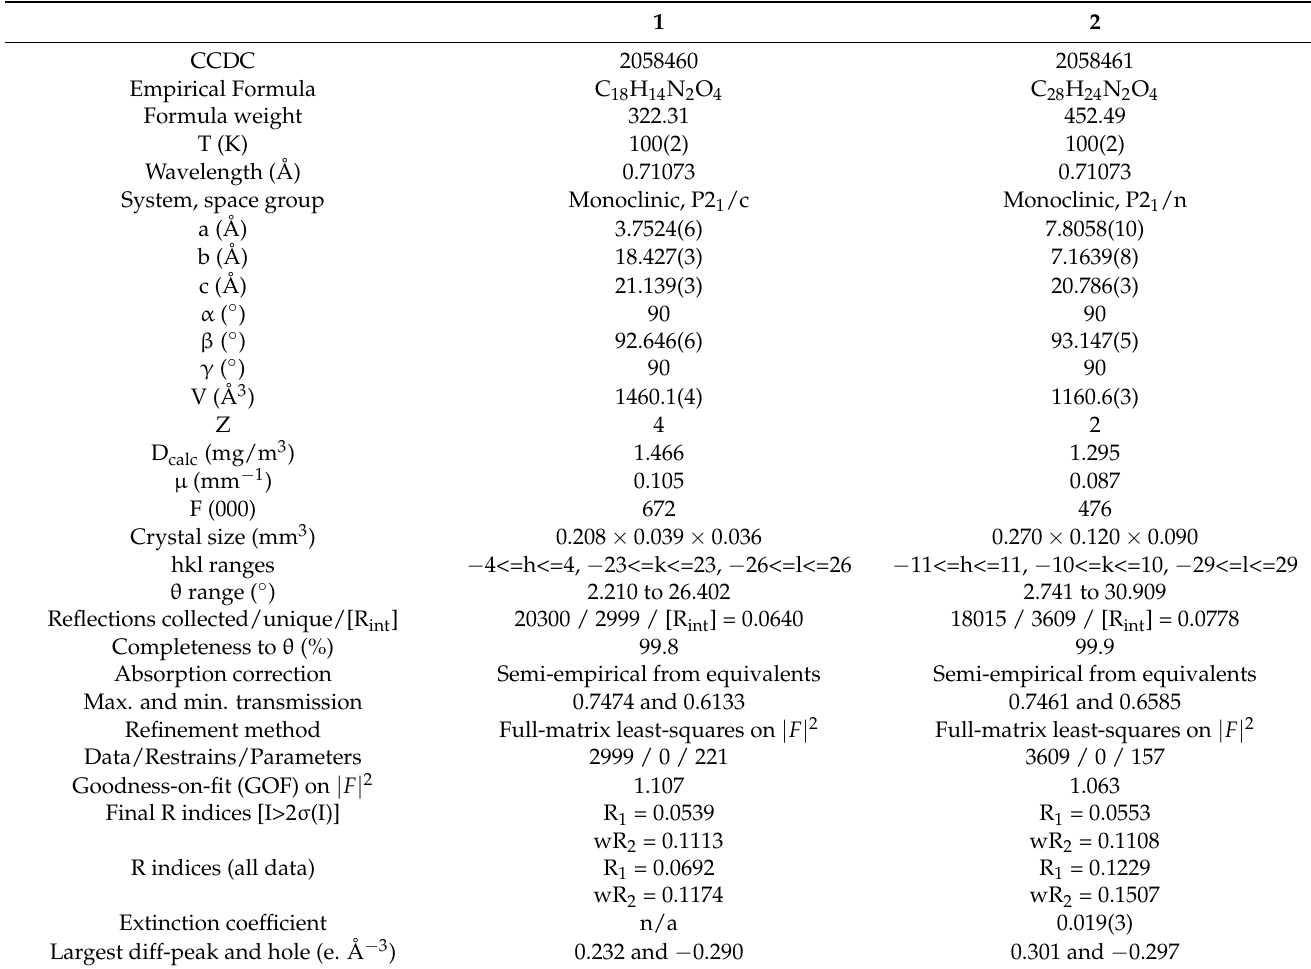
Table 1. Crystal data and structure refinement for 1 and 2